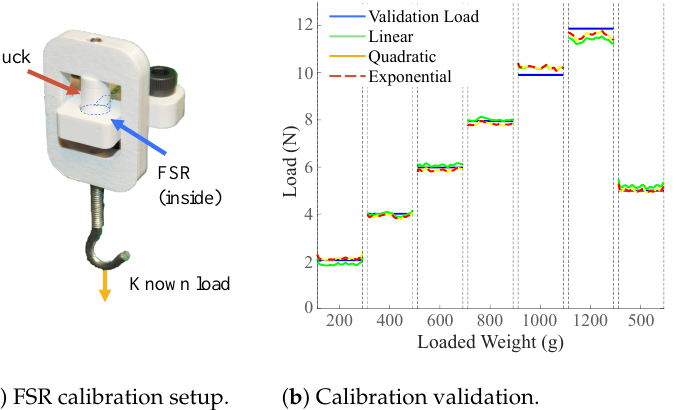
Figure 3. Calibration setup and results from a representative FSR (1 s of data under each loading condition). The linear relationship has the best performance across calibration tests across 24